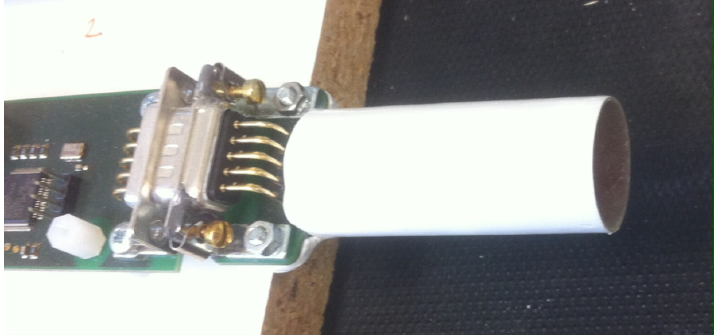
Figure 2. Sensor nozzle for a well-defined environment (total pressure conditions with a well-defined flow rate) for a fine wire temperature sensor. Inside the tube (not visible), the PCB (printed circuit board) to execute raw measurements and carry sensors is